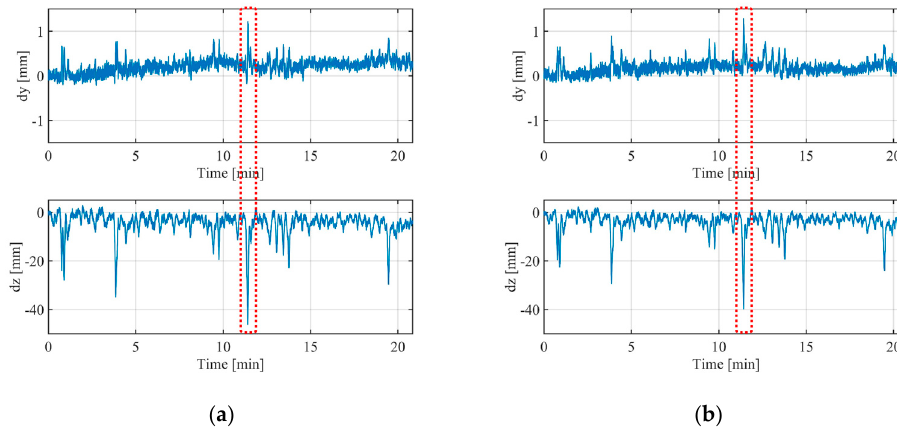
Figure 17. Displacement components of target at y = 85.9 m ( a ) and at y = 99 m ( b ). As a further application of this technique, we retrieved the direction of the displace- ment vector. Figure 18a,b show the retrieved direction of the two targets for the spotlighted stimulus (Figure 17). The displacement direction of the target at y = 85.9 m was inclined by an angle α = − 87.5 ◦ with respect to the y axis. The displacement direction of the target at y = 99 m was at α = − 87.9 ◦ .